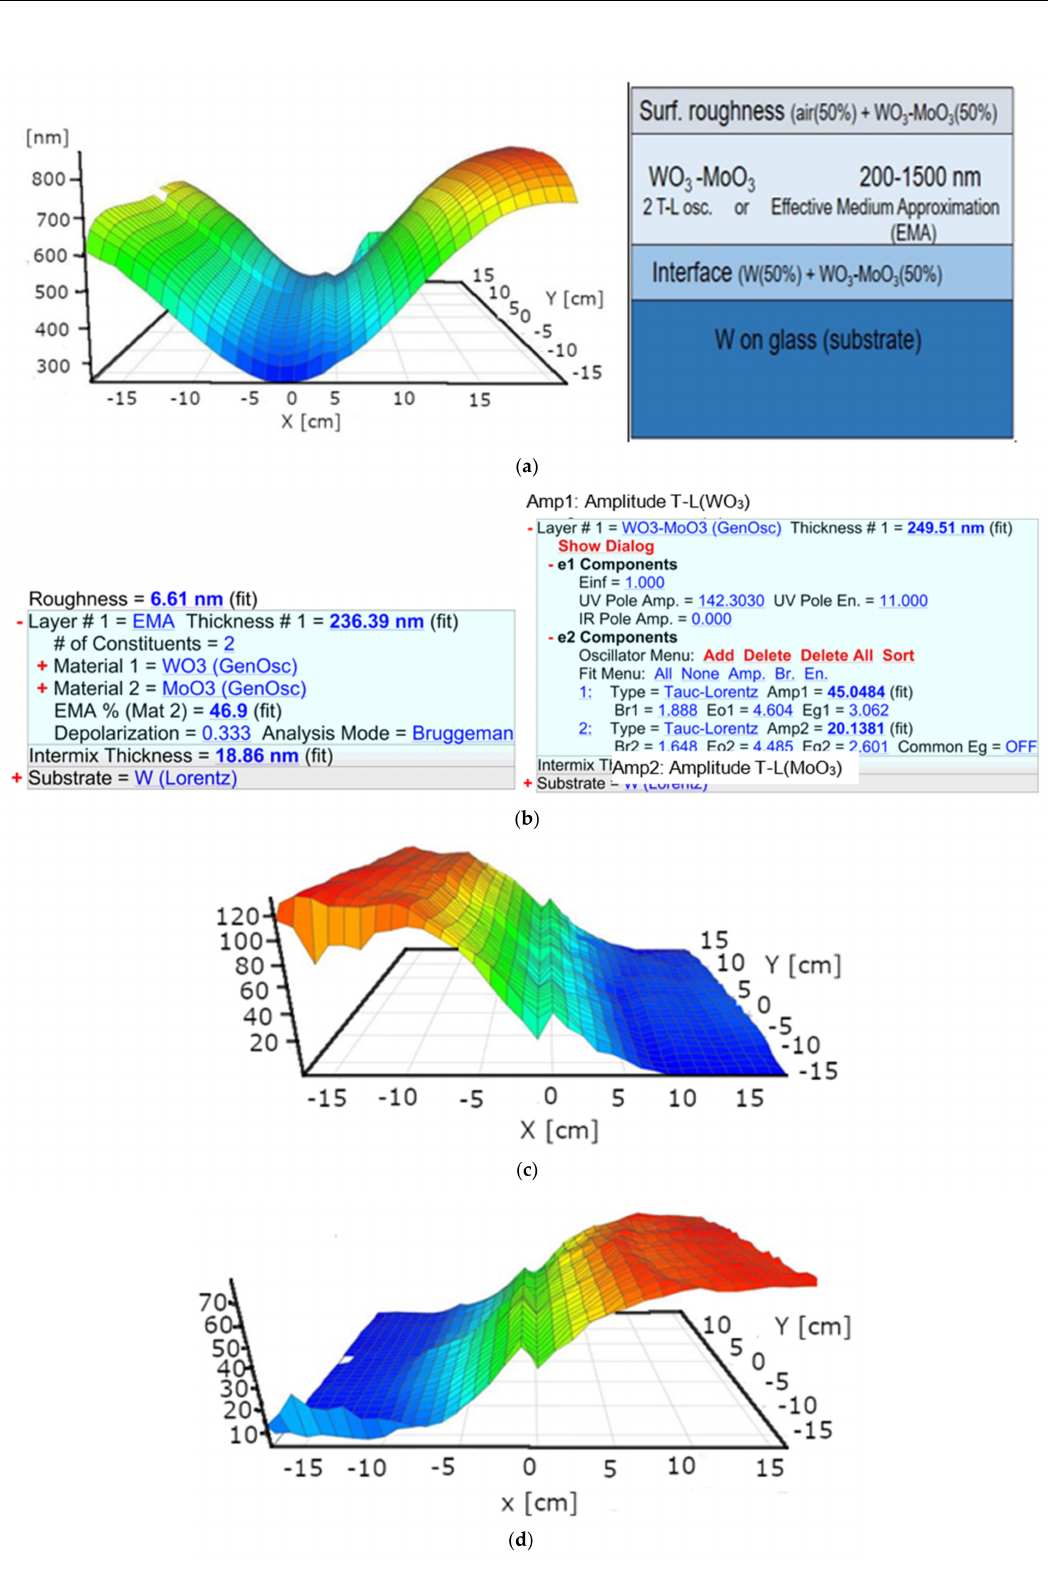
Figure 9. ( a ) Thickness-map and the schematic optical model; ( b ) two versions of the optical model: The Bruggeman Effective Medium Model (left), the 2-Tauc-Lorentz (2-T-L) oscillator model (right), “(fit)” show the fitted parameters; ( c ) Amp1: Amplitude-of-T-L(WO 3 )–map; ( d ) Amp2: Amplitude- of-T-L(MoO 3 )–map (the wrinkles at the center lines are artefacts caused by the manual “rotation” during the SE